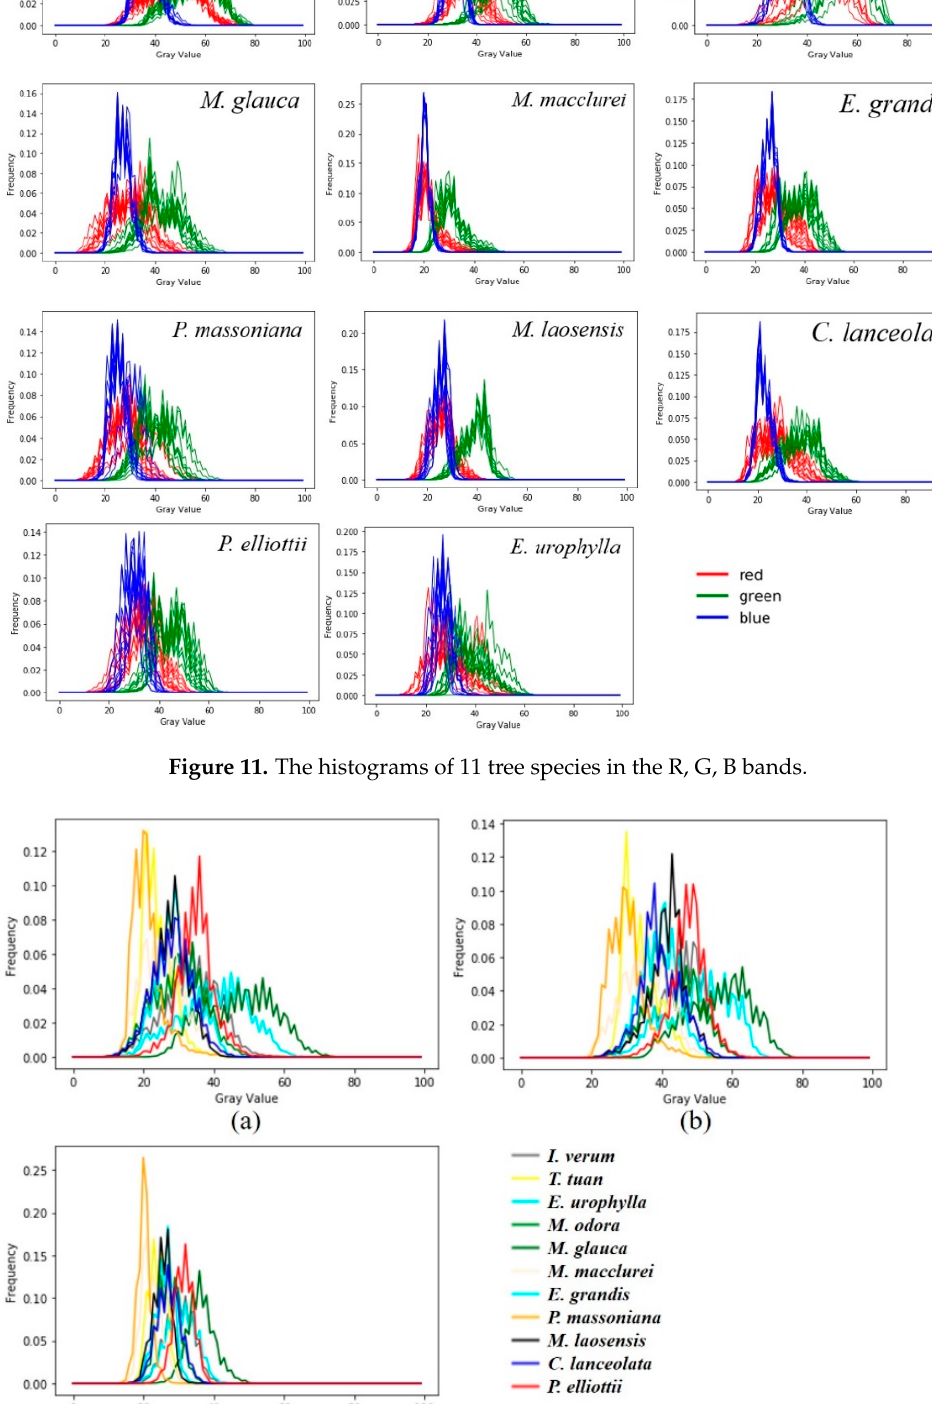
and the spectra show distinctive differences in different seasons. Figure 14a–k shows the profile curve generated by the LiDAR data for different tree species. The profile curves of the same tree species are similar. This similarity demon- strates that the features extracted from the LiDAR data are effective for distinguishing different tree species. Among the profile curves of 11 tree species, nine have one peak, and two have double peaks. In the curve with two peaks, the first peak is caused by the vege- tation under the trees, such as small shrubs. The second peak is caused by the character- istics of trees. When the forest stands are of the same species, the structure below the can- opy might be different, which may cause the deviation of the profile curve, such as for M. glauca and I. verum . In addition, the tree species in a forest stand may not be all the same, causing the waveform to deviate. Generally, the amount of deviation in the profile curve is only a small part of the total forest stand. To clearly show the difference in profile curves among the different tree species, Fig- ure 14l presents the results that integrate the profile curve of different tree species. Gen- erally, different tree species have different waveforms, including the locations of wave peaks and the shape of the waveform. Sometimes, the profile curves of certain tree species are nearly identical, such as P. elliottii and P. massoniana (Figure 14b,e). Therefore, the uti- lization of the profile curve alone cannot distinguish between P. elliottii and P. massoniana Fortunately, the histograms of P. elliottii and P. massoniana in the R, G, and B bands are distinctive. M. laosensis and C. lanceolata (Figure 14 h,j) can be easily distinguished using profile curves even though they have similar histogram and time-series curves.